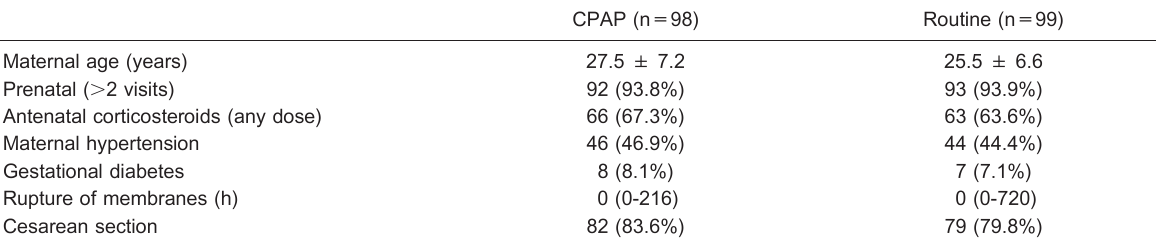
Table 1. Antenatal conditions according to the randomized groups.